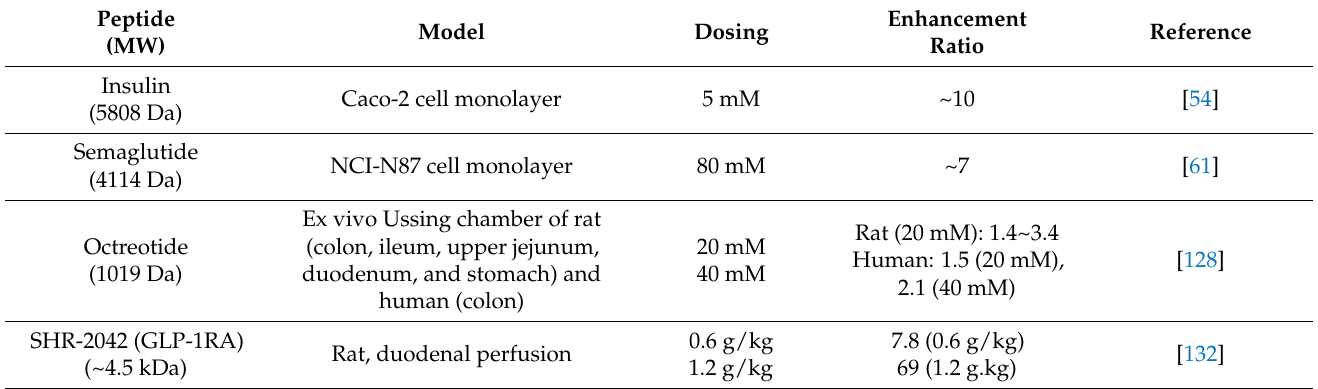
Table 4. Studies on the permeation enhancement of